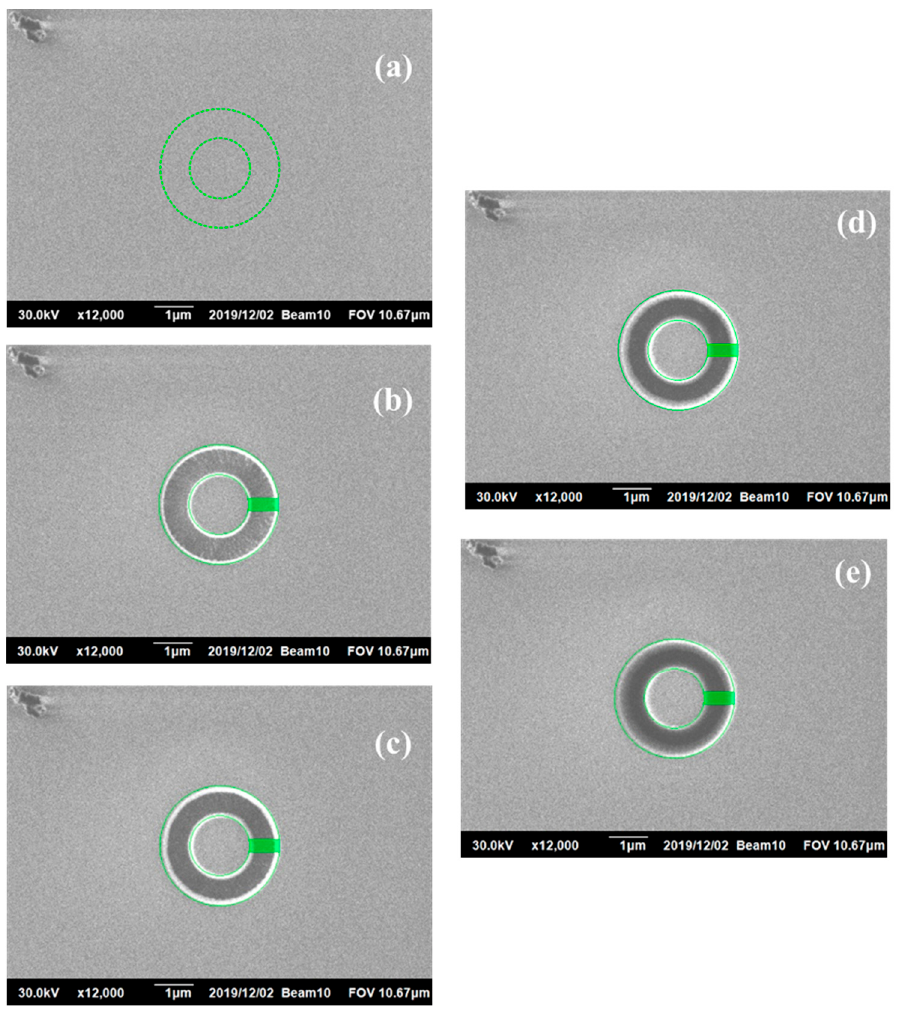
Figure 4. FIB-DIC (digital image correlation) images of ZrN thin film at a magnification of 12,000x. Milling depth to surface: ( a ) positioned simple before milling, 0 μ m; ( b ) first milling depth, 0.6 μ m; ( c ) second milling depth, 0.8 μ m; ( d ) third milling depth, 1.0 μ m; ( e ) fourth milling depth, 1.1 μ m.